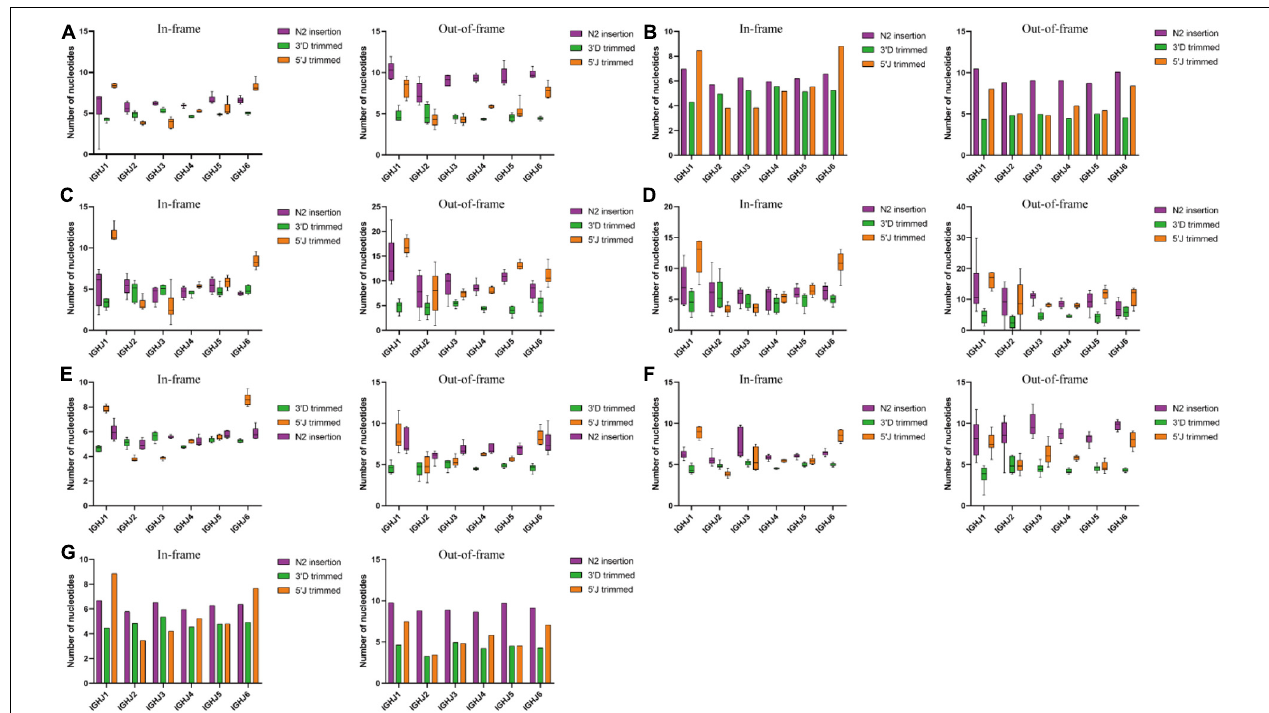
FIGURE 4 | 3 (cid:48) D trimmed, 5 (cid:48) J trimmed and N2 insertion at IGHD-IGHJ junction in the in frame and out of frame BCR-H repertoires from different subjects. (A) BCR-H repertoires from 6 Healthy volunteers. (B) BCR-H repertoires from public data. (C) IgM-H repertoires from volunteers before and after immunization with the HBV vaccine. (D) IgG-H repertoires from volunteers before and after immunization with the HBV vaccine. (E) BCR-H repertoires from SLE volunteers. (F) BCR-H repertoires from breast cancer volunteers. (G) BCR-H repertoires from volunteers with a high titer of HbsAb. We used bar chart for data of sample groups with n = 2 (B) and IMGT (C) , while used box plot for data of sample groups with n ≥ 3 by a one-way ANOVA with Bonferroni correction (A,D–G)